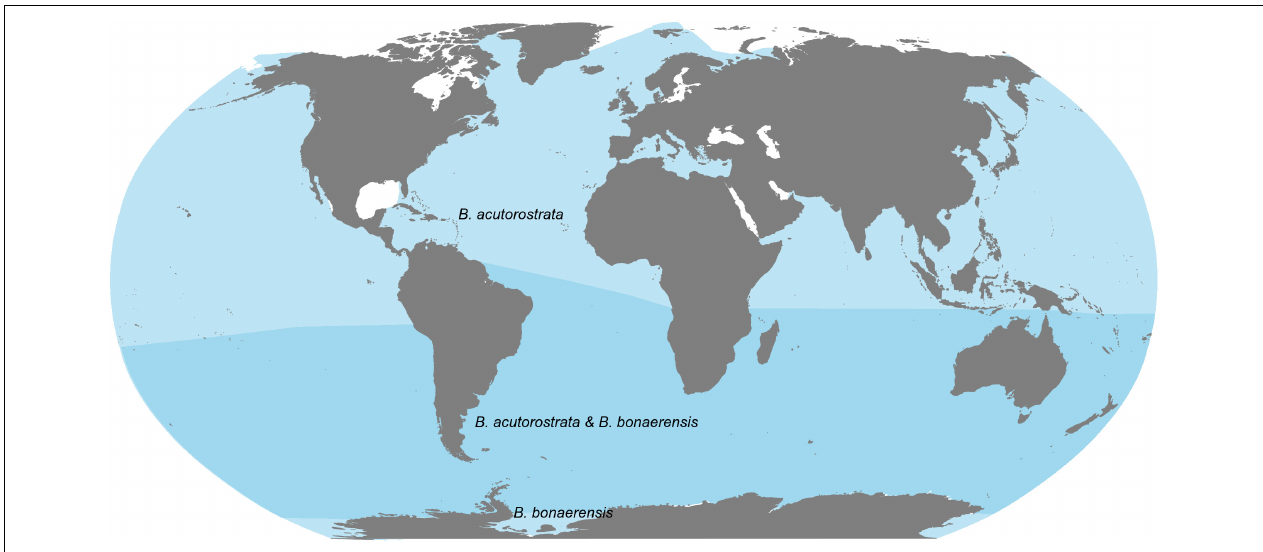
FIGURE 1 | Range map of Common ( Balaenoptera acutorostrata ) and Antarctic ( Balaenoptera bonaerensis ) minke whales. Source for presented species ranges: International Union for Conservation of Nature (IUCN) (Cooke et al., 2018a,b).